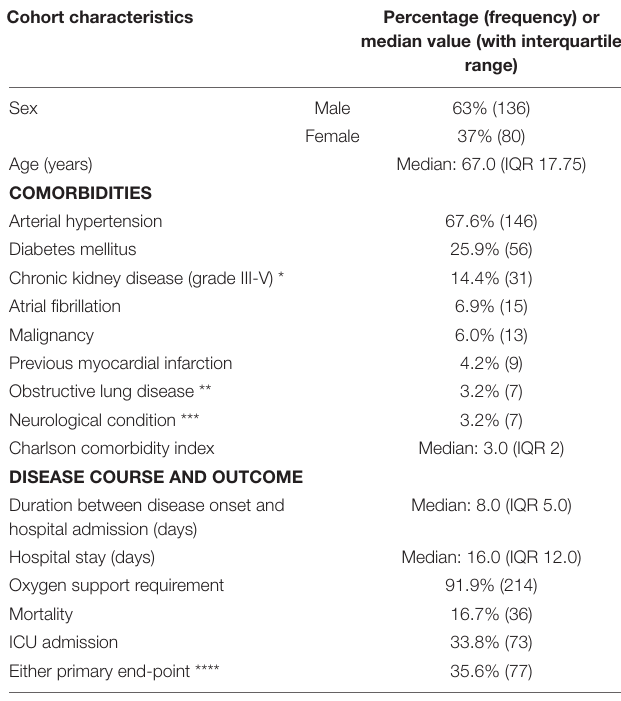
TABLE 2 | Cohort characteristics regarding socio-demographic data, comorbidities, and data concerning disease course and